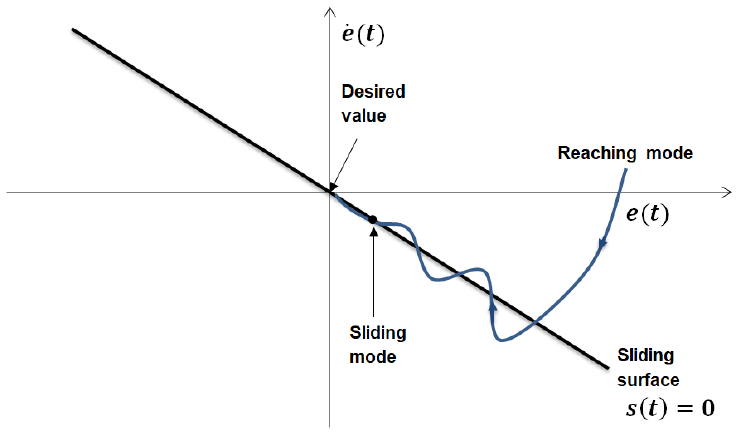
Figure 23. Phase plane under